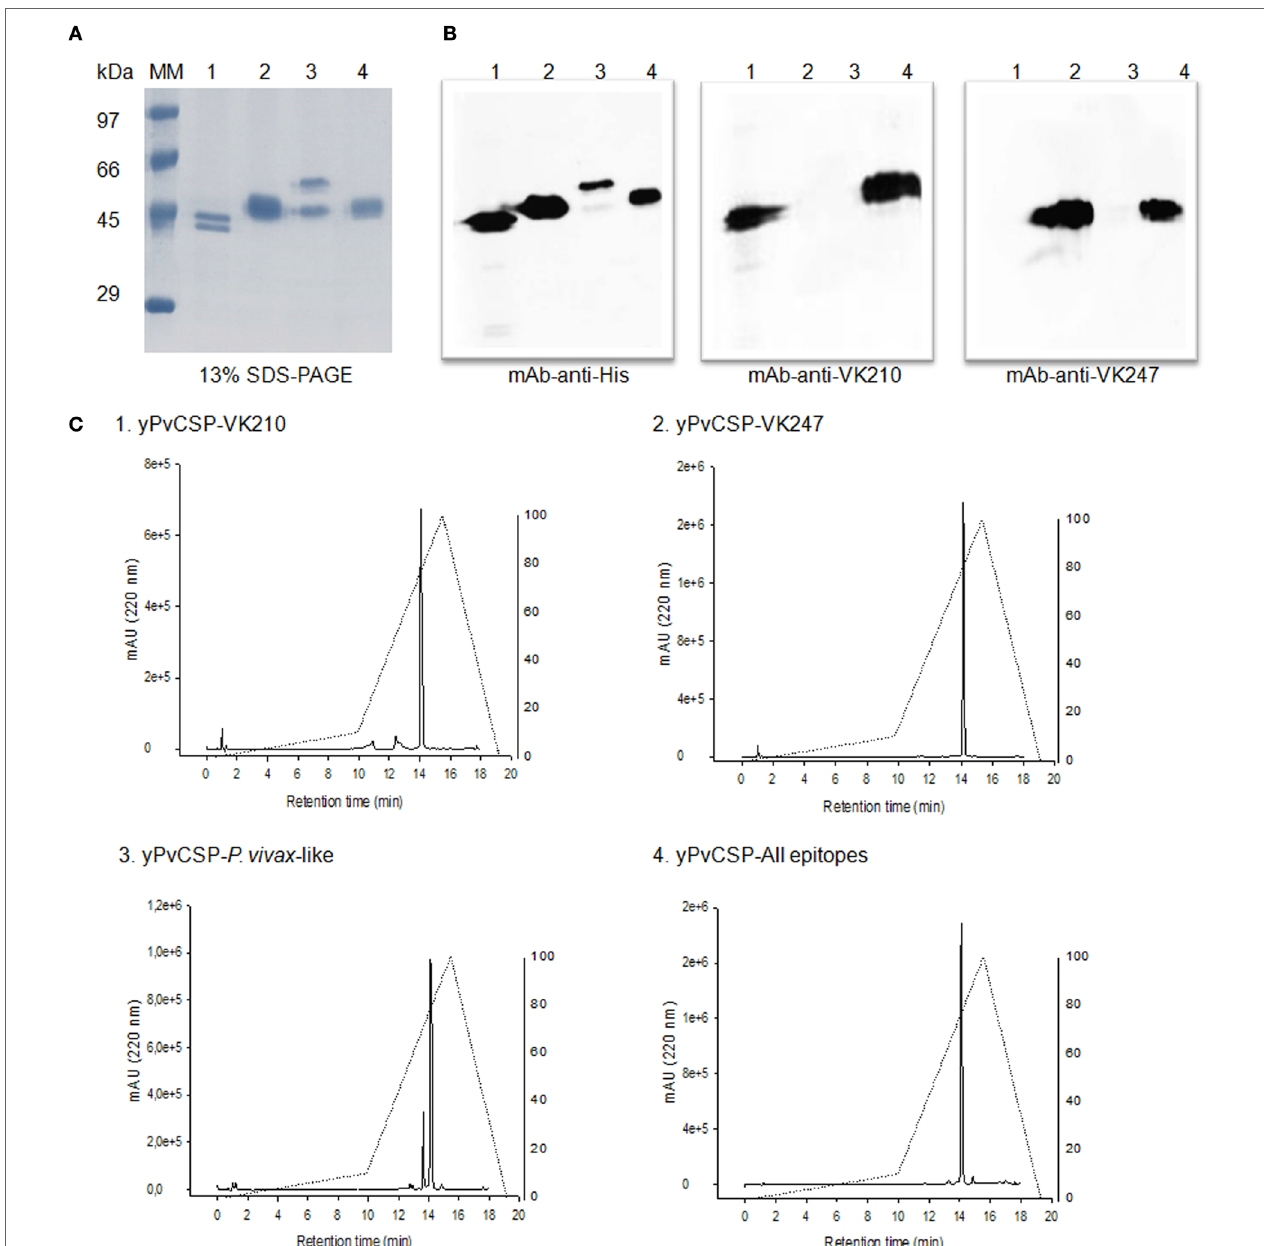
FigUre 2 | Purification and biochemical characterization of the Plasmodium vivax circumsporozoite protein (CSP) recombinant proteins. (a) 13% SDS-PAGE under reduced conditions stained with Coomassie blue. Proteins migrate between 50 and 55 kDa. Fractions were 2 µg of: (1) yPvCSP-VK210, (2) yPvCSP-VK247, (3) yPvCSP- P. vivax -like, and (4) yPvCSP-All epitopes. (B) Western blot using 1 µg of the same fractions of proteins described above. Antibodies used were monoclonal antibody (MAb) anti-His, MAb VK210 (2F2), and MAb VK247 (2E10.E9). The secondary antibody used was anti-mouse IgG HRP-labeled, and detection was performed by ECL assay. (c) The purity of proteins, after the combination of chromatographic methods, was analyzed by reverse-phase high-performance liquid chromatography (RP-HPLC), in which the gradient elution was developed combining 0.1% trifluoroacetic acid (TFA) in water and 0.1% TFA in 90% acetonitrile, 24°C, 1 mL/min for 40 min, in a C18